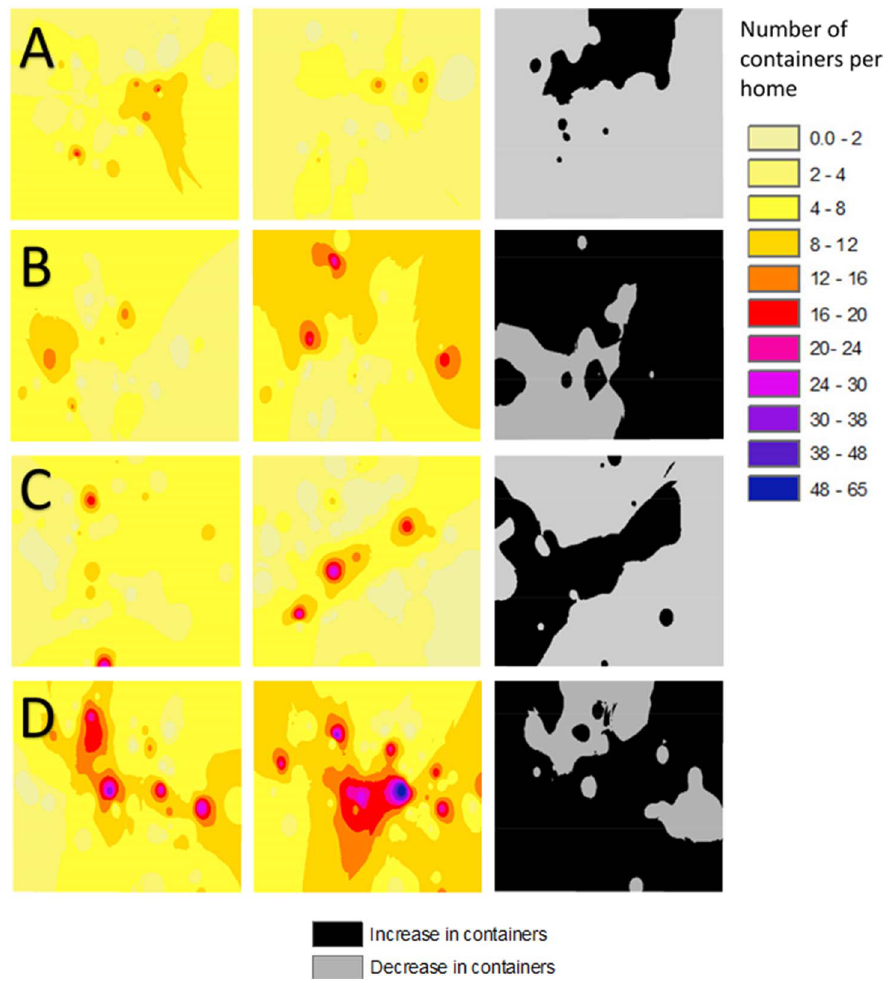
Figure 3. Spatial distributions of the number of container habitats per home sampled in sites receiving education (treatment sites) and those not receiving education (control sites). The columns represent the number of containers before education, (1 st column) immediately following education (2 nd column) and the difference between the two (3 rd column, in black & grey). In homes with no change in container number, they were classified along with a decrease in containers. The rows summarize Monmouth county treatment site (A), Monmouth county control site (B), Mercer county treatment site (C), and Mercer county control site (D).